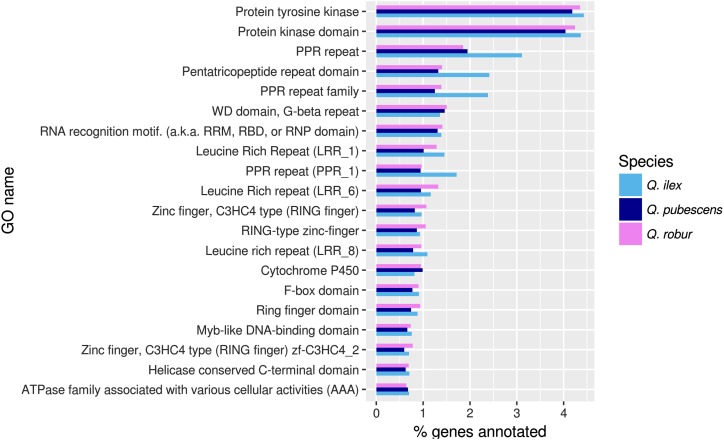
Pfam domain distribution. 20 mostly assigned Pfam domains for Q. robur in comparison to Q. pubescens and Q. ilex in % of annotations relative to all Pfam-annotated genes in that species.